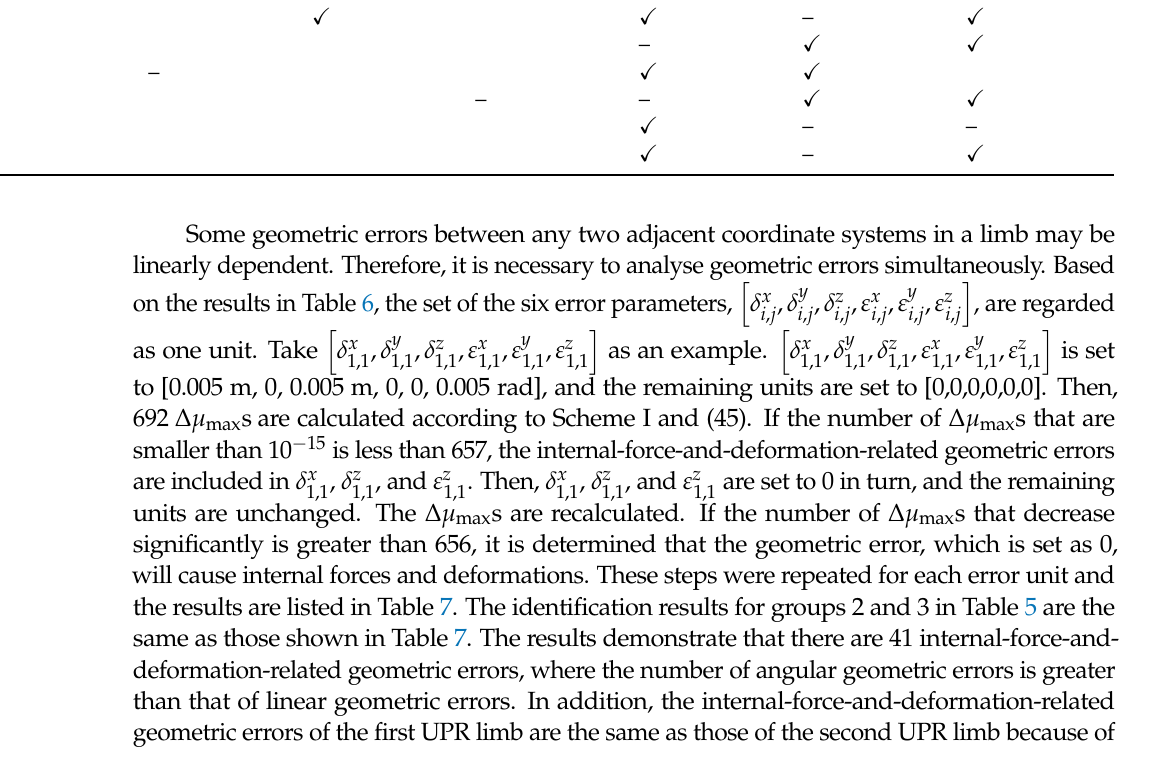
Table 5. Specified geometric errors [13,26] for geometric error identification. Symbols Group 1 Group 2 Group 3 Units δ i , j 0.005 0.001